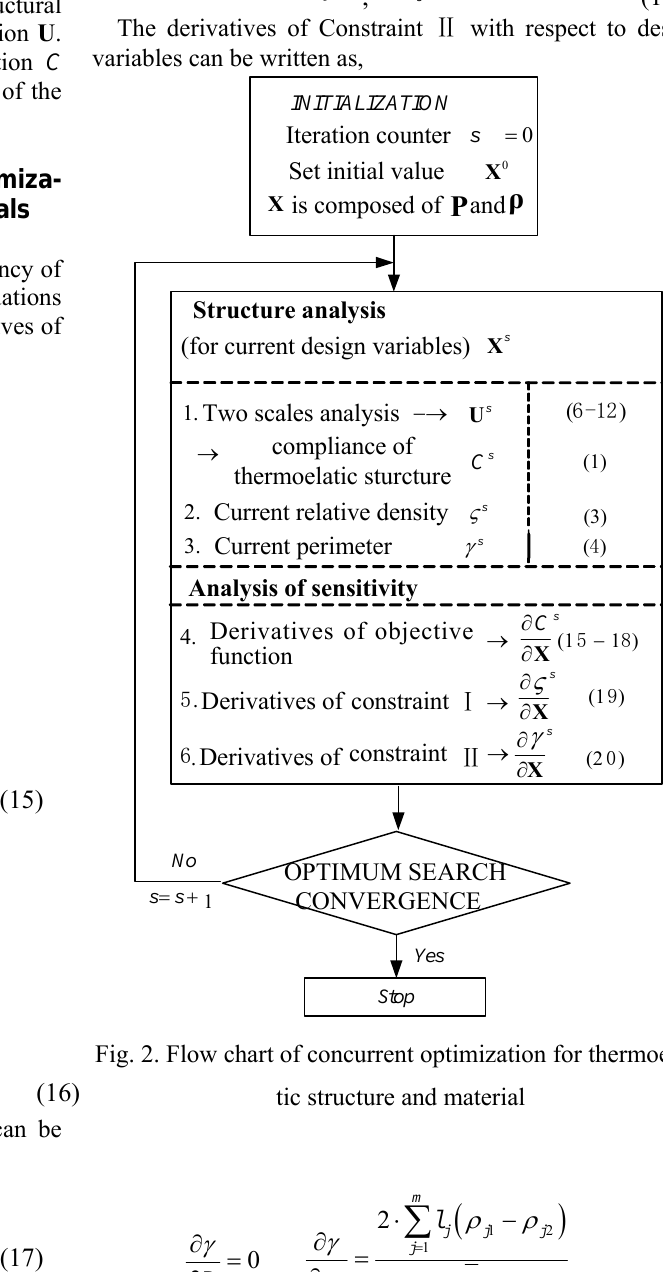
Fig. 2. Flow chart of concurrent optimization for